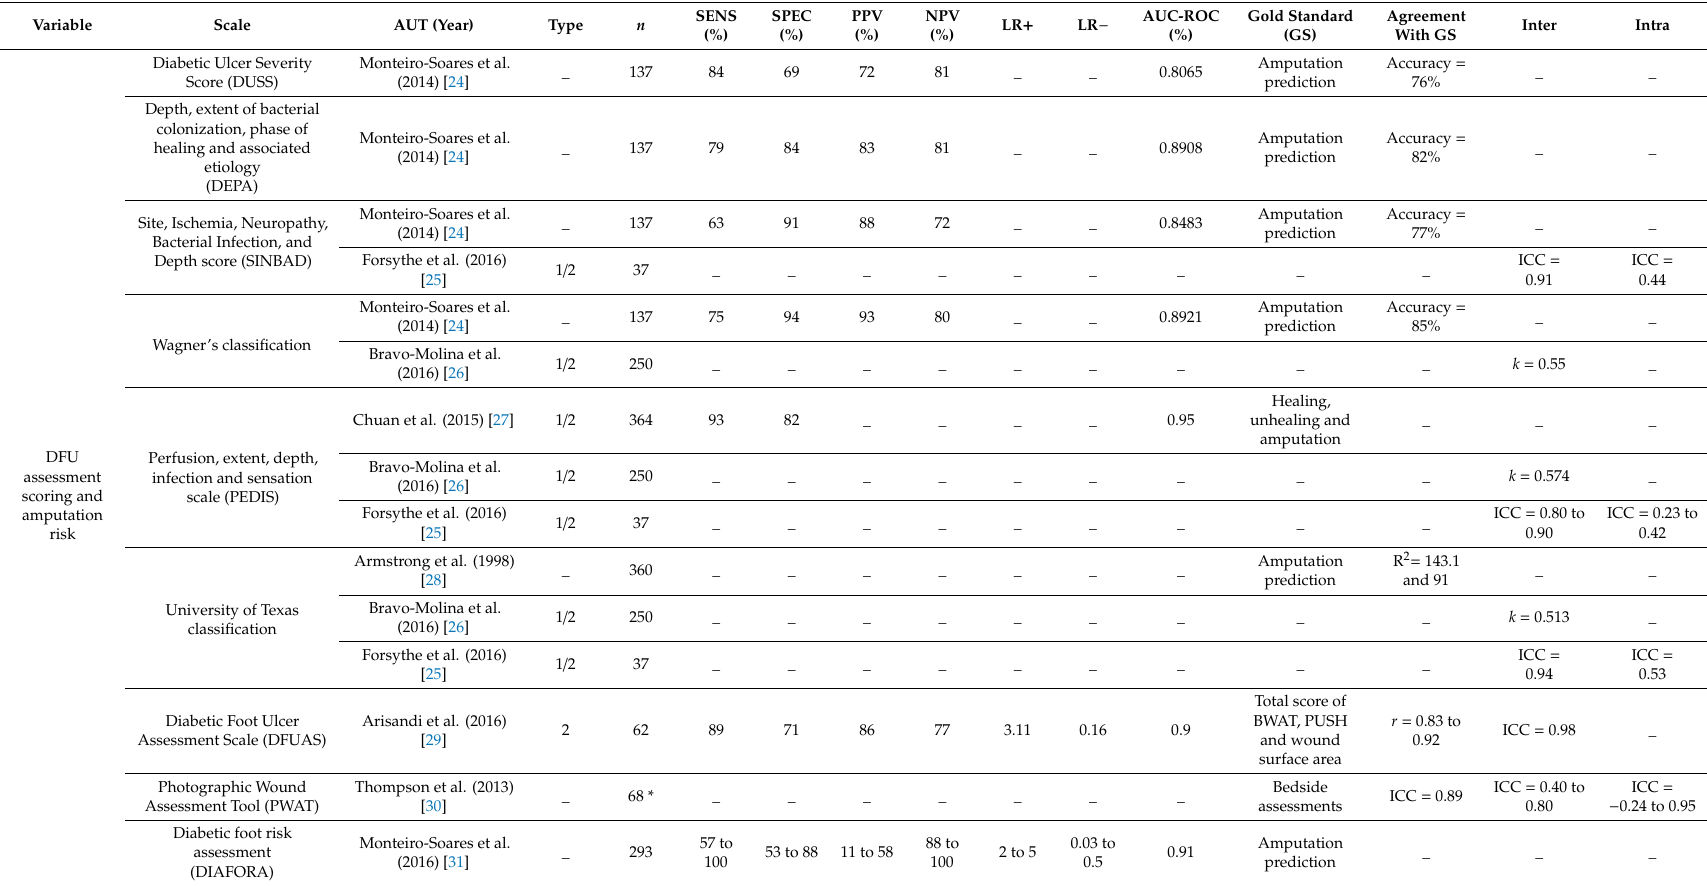
Table 2. Clinician assessment tools validated for the assessment of diabetic foot ulcer (DFU) related